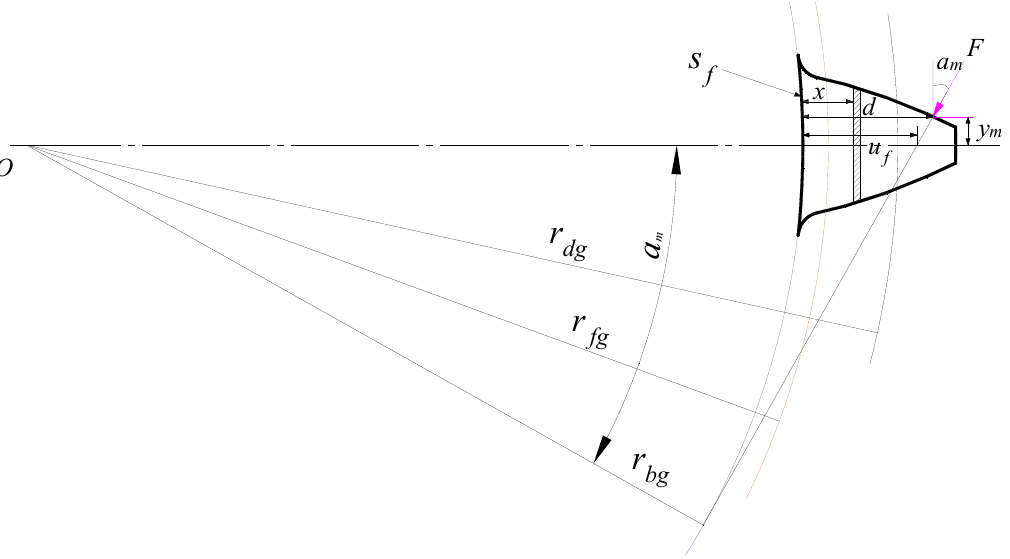
Figure 8. Modelling of nonuniform cantilever beam of spur gear.